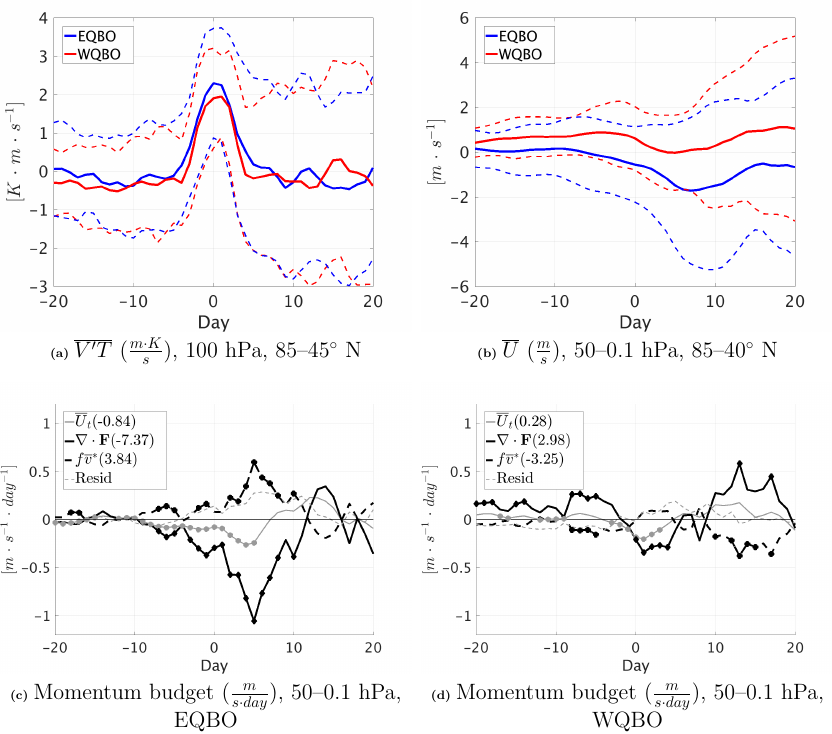
Figure 5. Time lag composites for the upward wave pulse events during October in the 3DO 3 run. (a) V (cid:48) T (cid:48) averaged over 85–45 ◦ N at 100mb. (b) – (d) The extratropical stratospheric averages (50–0.1mb, 85–40 ◦ N, marked by the green rectangle in Fig. 6a of U (b) ; dashed lines show ± 1 standard deviation. (c) – (d) Momentum budget terms for east and west QBO events, respectively. Shown are the total time tendency (thin gray), f v ∗ (dashed black), and the residual (gray dashed) with their integrated value from days − 10 to 20 denoted in the figure